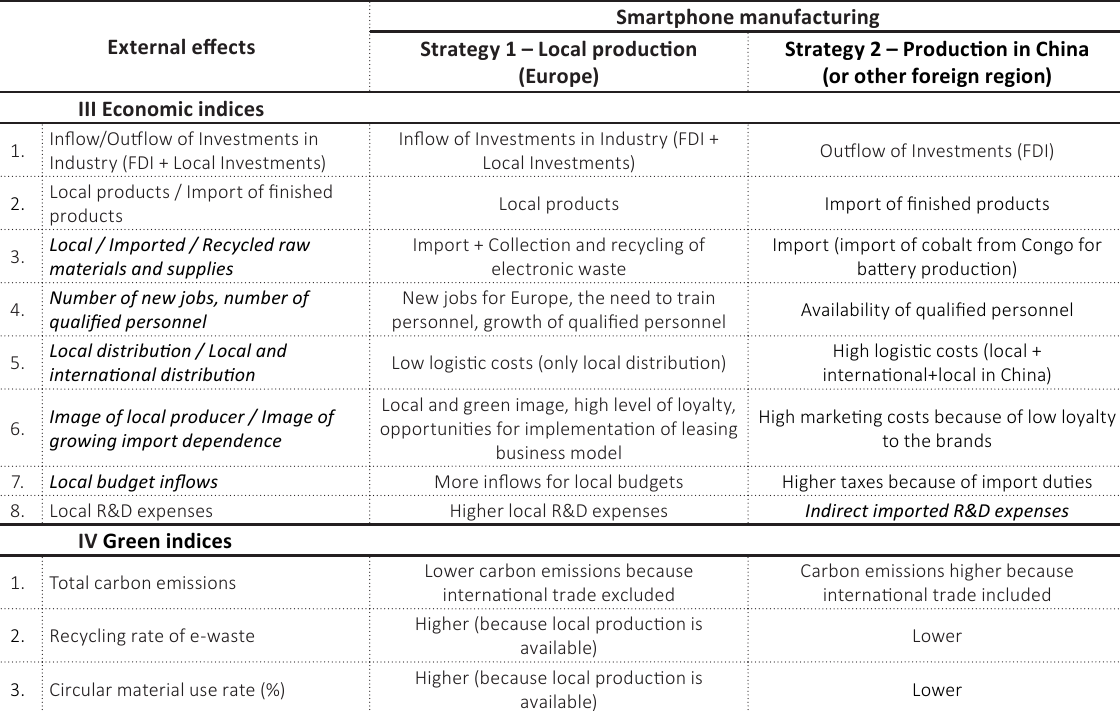
Table 2. Comparative matrix of economic and green impact effects